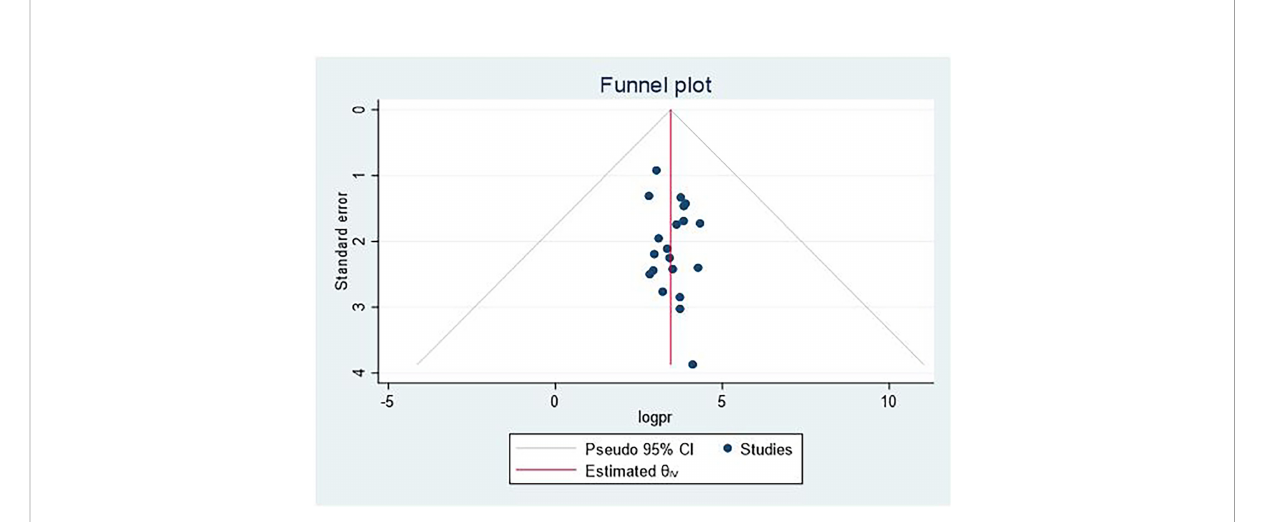
FIGURE 5 Funnel plot for the publication bias.